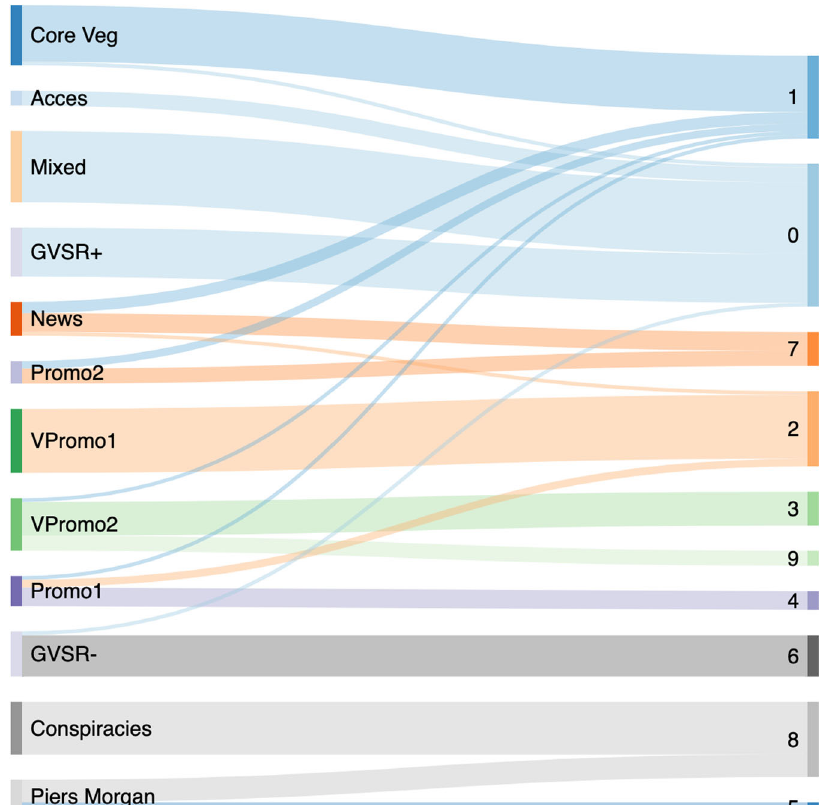
Fig. 3 Flow chart to illustrate the composition of the communities in the projection network in terms of the retweet network communities. Retweet network communities listed on left. Projection network communities on right. Retweet network communities retain their labels while projection network communities are denoted with arbitrary digits. E.g., Community 1 in the projection network signi fi es that members of the following communities identi fi ed in the retweet network have overlapping audiences: Core Veganuary activist, News, Promo2, VPromo2, and